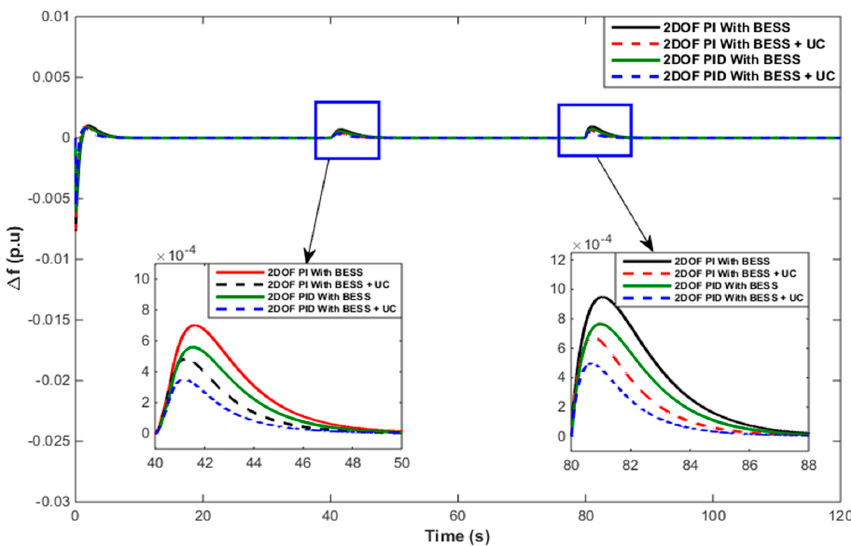
Figure 13. Comparative performances of the frequency responses of BESS (case 1) and BESS + UC (case 2) with the FPA-optimized 2DOF-PID-controller-based hybrid energy systems.